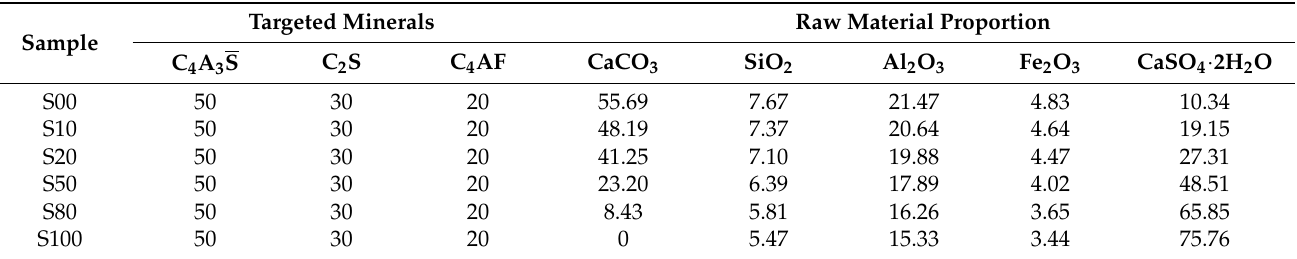
Table 1. Target mineral composition of the clinker and chemical reagent proportions in the raw materials to prepare 100 g